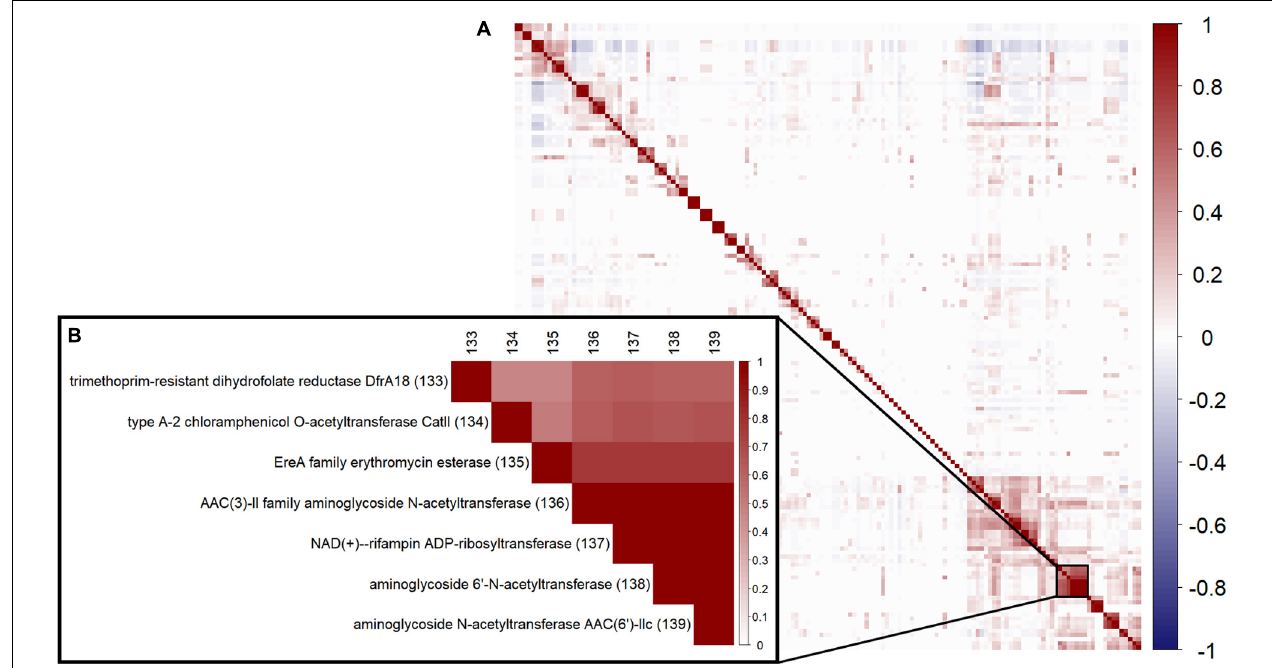
FIGURE 2 | Correlation between the 152 ARGC found in the analyzed samples. (A) Overall pairwise correlation plot. (B) A zoom-in example of a highly correlated group of ARGC. Numbers in parentheses are the same serial numbers as in columns provided for easy matching.